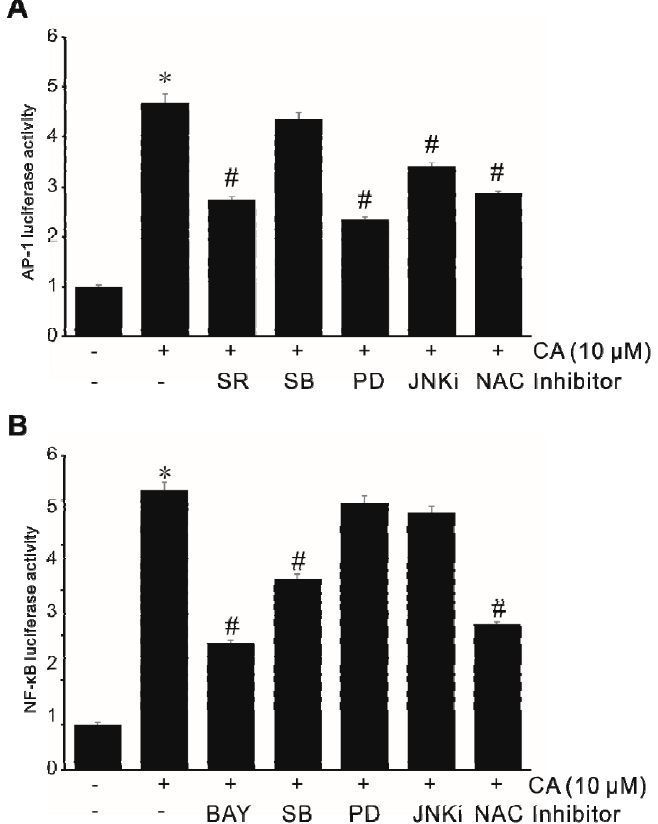
Figure 6. CA-induced AP-1 and NF- κ B by ROS generation and MAPK pathway activation in SW620 cells. ( A ) SW620 cells were transiently transfected with the AP-1 luciferase reporter construct. Transfected cells pretreated with 2 µ M SR-11302 (SR), 30 µ M SB-203580 (SB), 30 µ M PD-98059 (PD), and 30 µ M JNKi or 5 mM NAC for 1 h were incubated with 10 µ M CA for 6 h and then luciferase activity was determined using a luminometer. Data represent the mean ± standard deviation (SD) from triplicate measurements. * p < 0.05 versus control; # p < 0.05 versus CA only. ( B ) SW620 cells were transiently transfected with the NF- κ B luciferase reporter construct. Transfected cells pretreated with 10 µ M BAY-11-7082 (BAY), 30 µ M SB-203580 (SB), 30 µ M PD-98059 (PD), and 30 µ M JNKi or 5 mM NAC for 1 h were incubated with 10 µ M CA for 6 h and then luciferase activity was determined using a luminometer. Data represent the mean ± standard deviation (SD) from triplicate measurements. * p < 0.05 versus control; # p < 0.05 versus CA only.